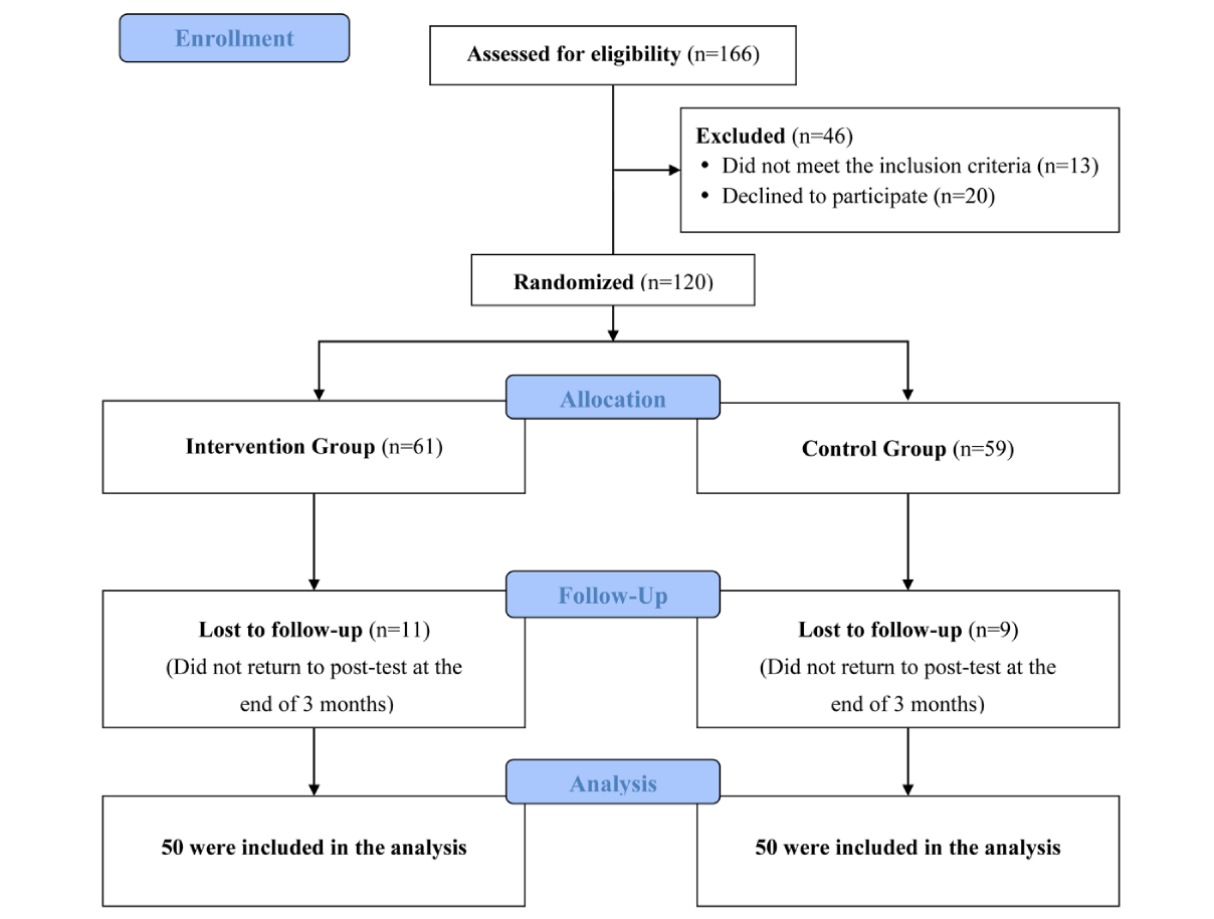
Figure 1. Flowchart of study sample